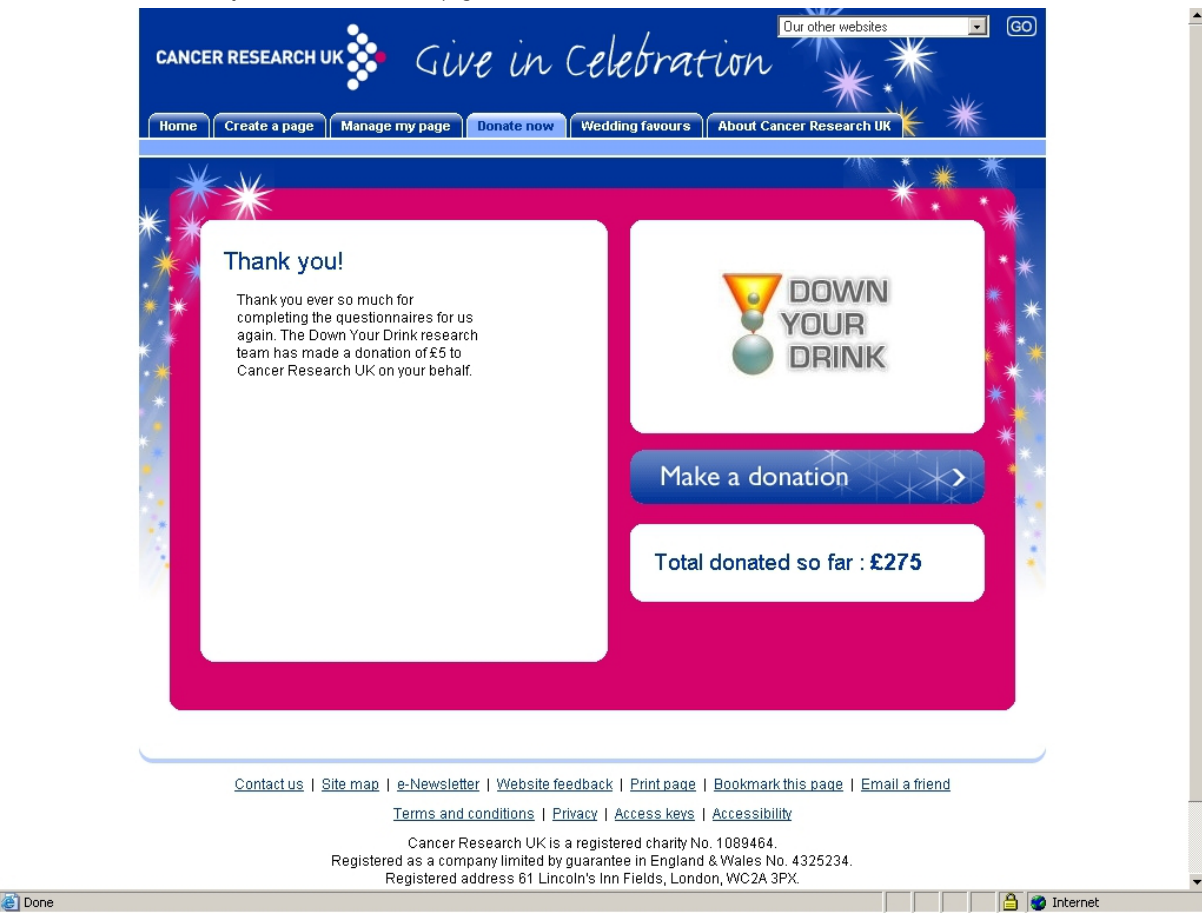
Figure 2. Screen shot of charity donation confirmation